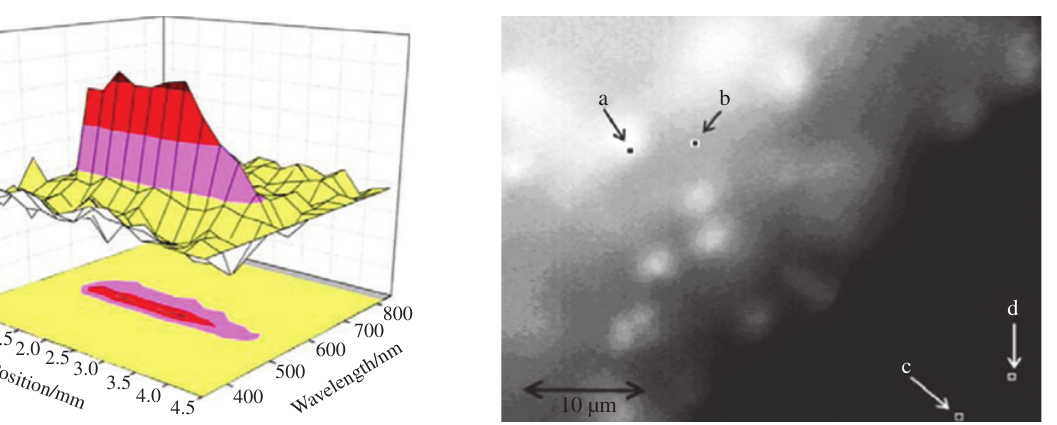
Figure 23 Fourier transform hyperspectral imaging of a lemon leaf surface pretreated with rhodamine 6G crystals after application of a droplet of Romectin (upper left: for example, points a and b) and with no pesticide (lower right: for example, points c and d) ( Hake et al. 2007 ).